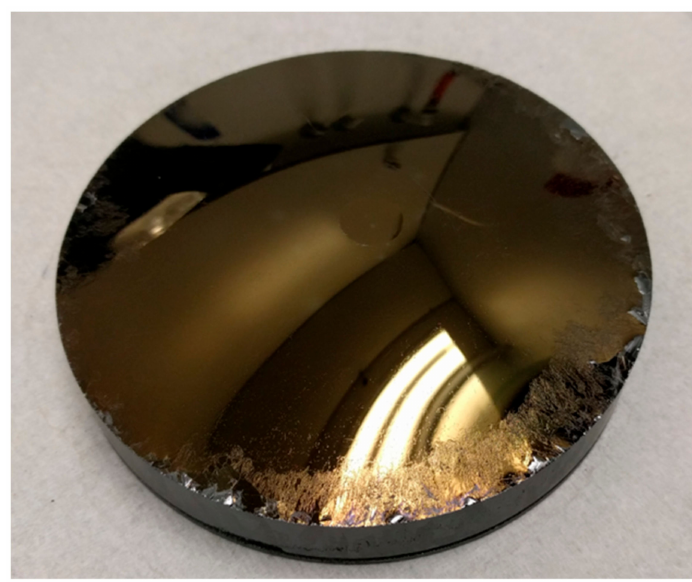
Figure 5. Optical image of the 100 mm SiC boule grown using the SIKA